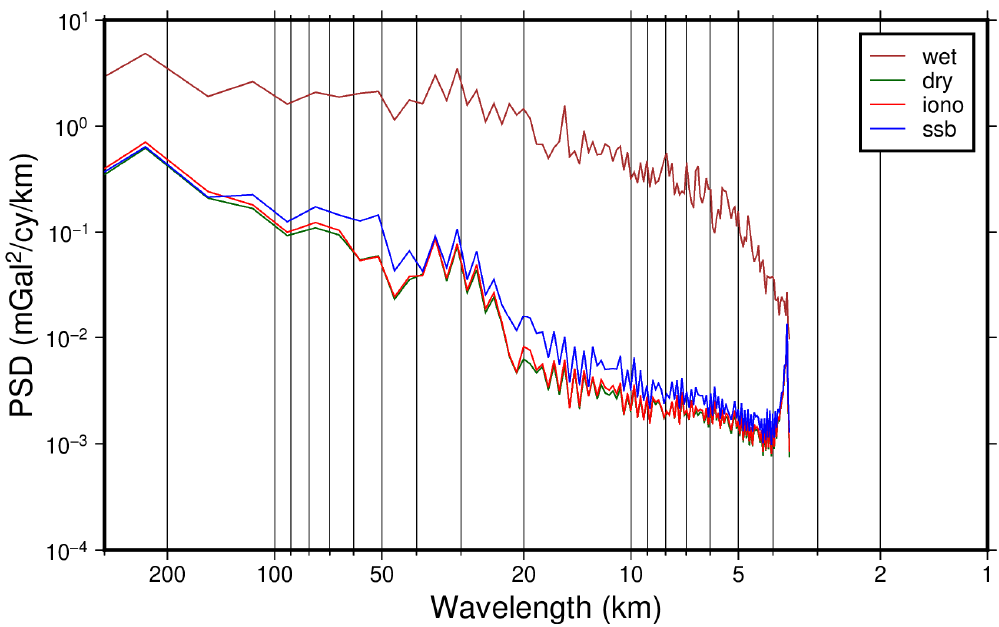
Figure 15. Error PSD of GA.